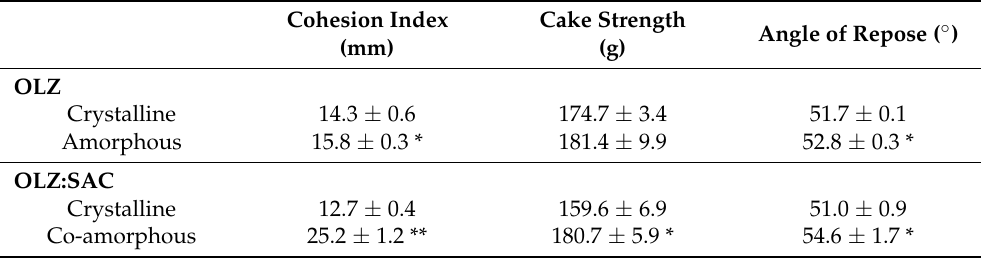
Table 2. Cohesion index, cake strength, and angle of repose of pure OLZ and physical mixtures of OLZ and SAC in both crystalline and (co-)amorphous forms. Cohesion Index Cake Strength (mm) (g) OLZ